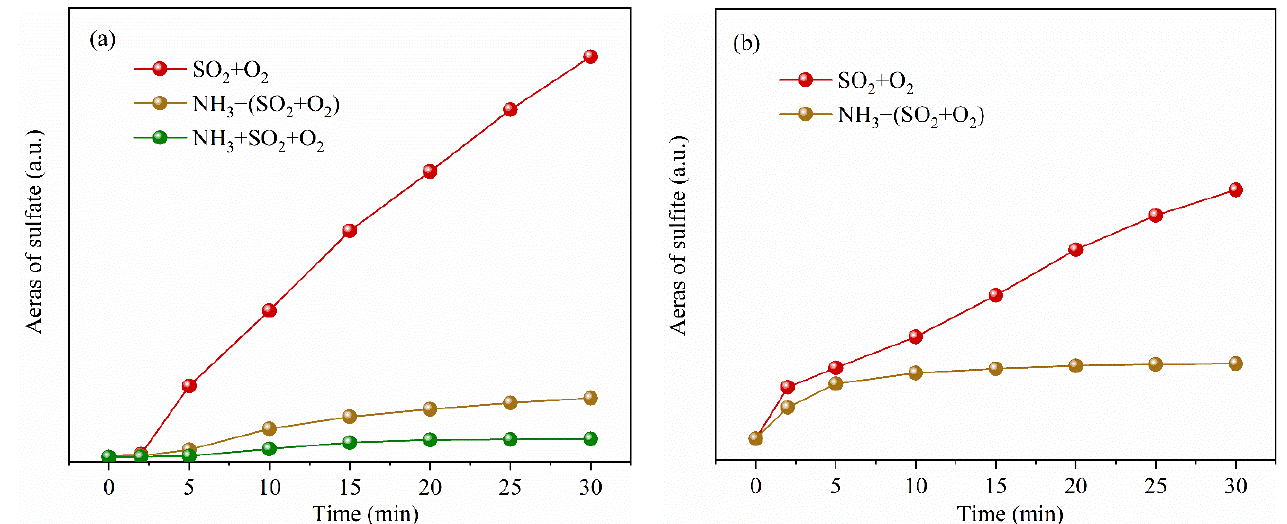
Figure 6. Evolution of ( a ) typical sulfate bands (1300–1256 cm − 1 ) and ( b ) sulfite band (925 cm − 1 ) as a function of time over CeNbTi catalysts that were treated with different poisoning procedures.